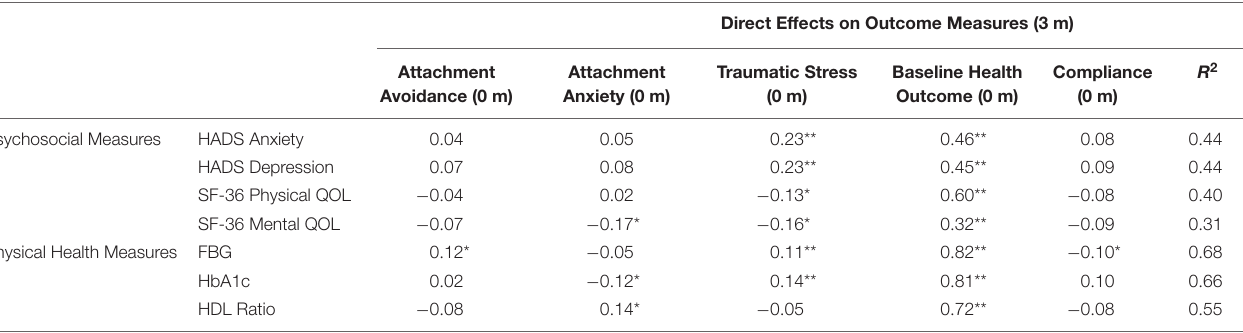
TABLE 3 | Standardized direct effects and R 2 values for multivariate structural equation model.